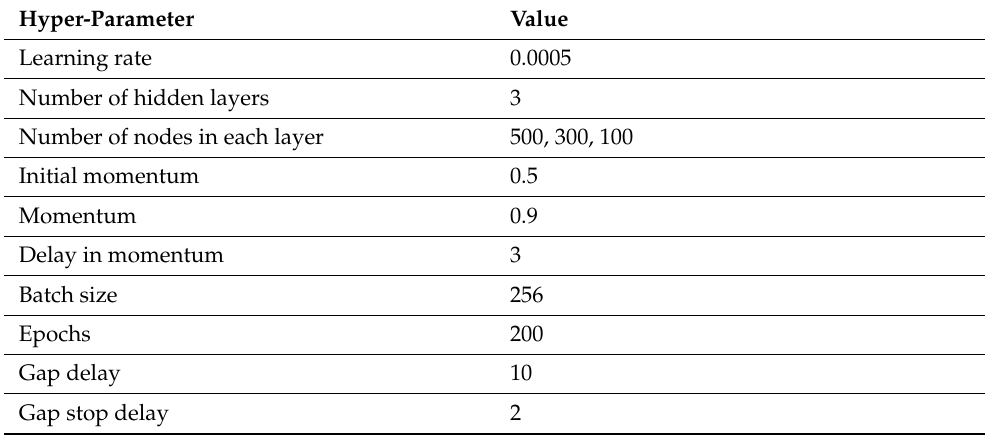
Table 1. Hyper-parameter setting of